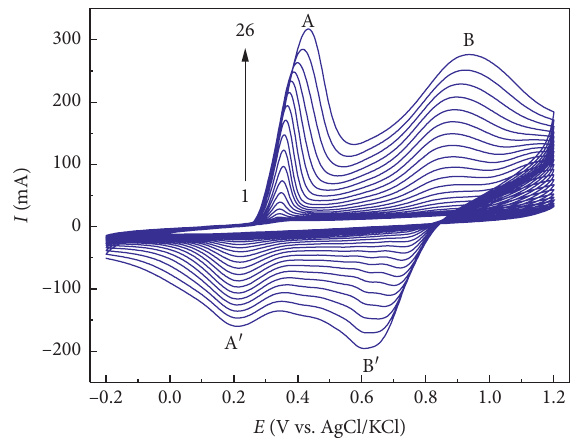
Figure 1: CVs recorded during electrodeposition of polyaniline onto the 316L electrode from ethanol solution containing 0.1M aniline and 0.5M H 2 SO 4 at scan rate 30mV/s.